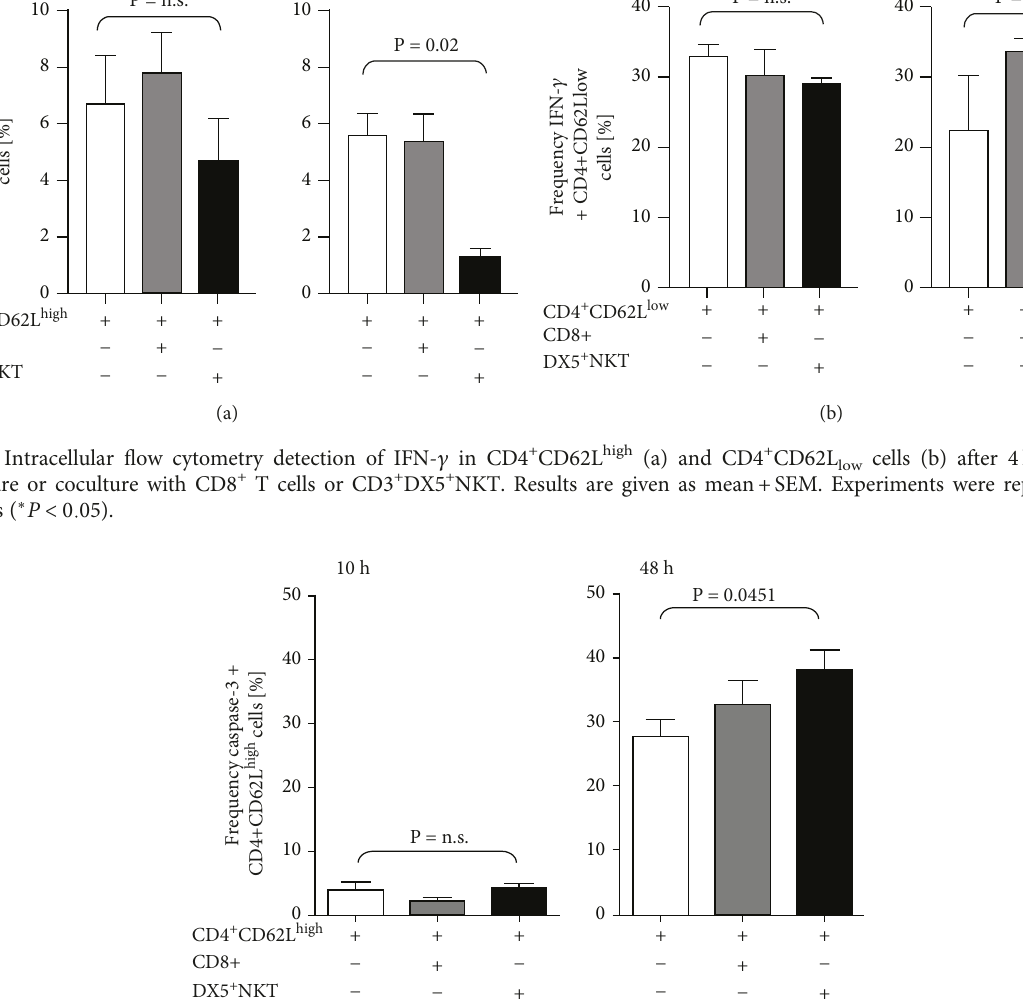
Figure 3: Intracellular fl ow cytometry analysis of caspase-3 in CD4 + CD62L high cells after 10h and 48 h of monoculture or coculture with CD8 + T or CD3 + DX5 + NKT cells. Results are given as mean +SEM. Experiments were repeated at least three times ( ∗ P < 0 05